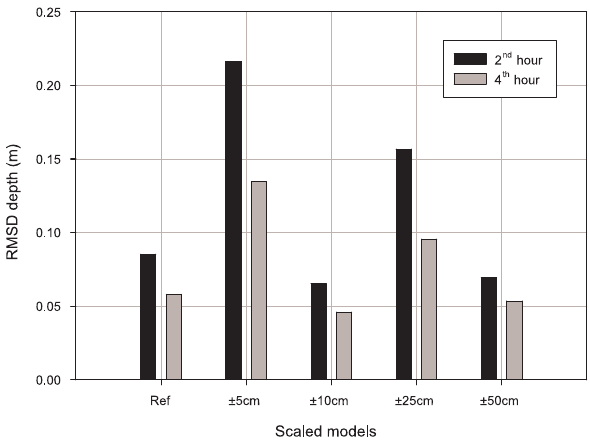
Fig. 10. RMSD values for depth derived results obtained with a distributed roughness parameterisation are compared with those ob- tained using a constant roughness height, for the 2nd and 4thh of the simulation.